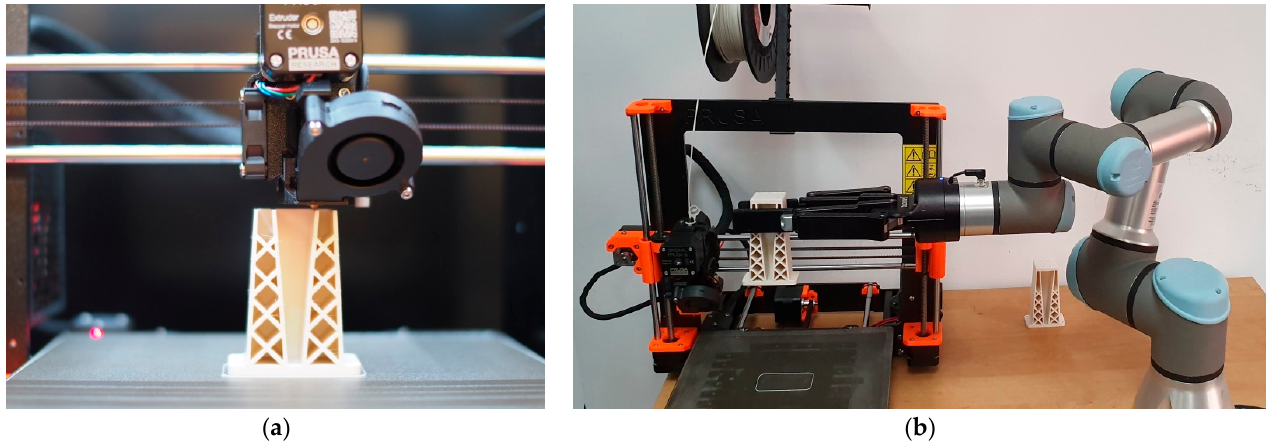
Figure 4. ( a ) Process control with the application of a camera; ( b ) Collaborative robot (Universal Robot UR3) with a 3D printer.